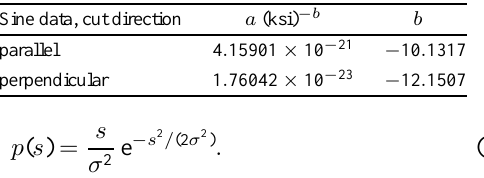
Curve fit constants for nickel data of the form N ( s ) = as